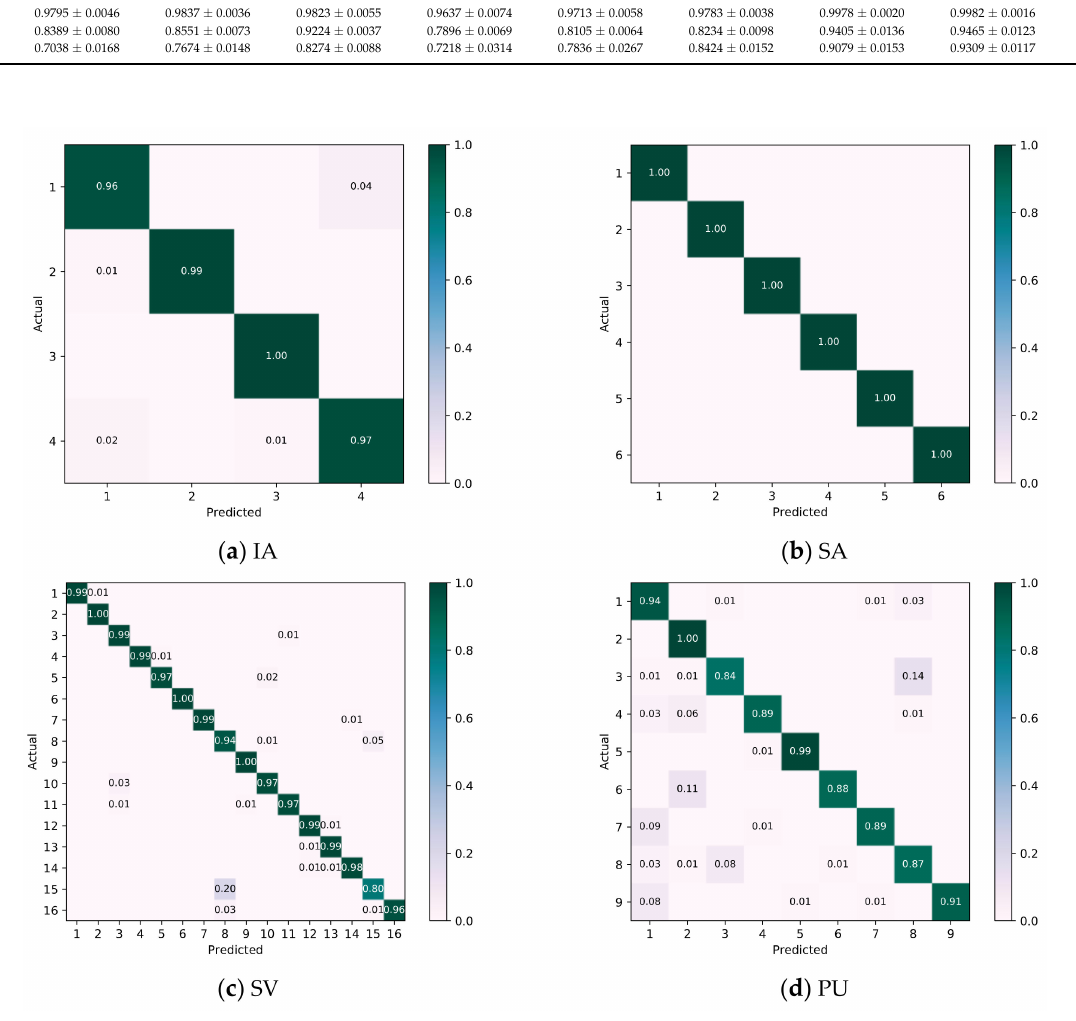
Figure 8. The confusion matrices of the presented GCN for different datasets, corresponding to the experiment with five random runs. ( a ) The IA dataset was at the 5th random run, ( b ) the SA dataset was at the 3rd random run, ( c ) the SV dataset was at the 3rd random run, and ( d ) the PU dataset was at the 2nd random